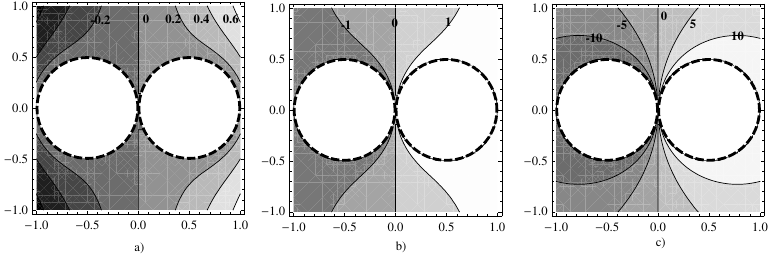
Figure 3. Modulus of the flux in the domain with a 2 = − a 1 = 0 . 5, δ = 0 . 01 in the presence of the external flux (1 , 0) and the dipole α of intensity α . Data and u 0 are for: a) z α = 0, u 0 = 0 . 070534; b) α = 0 . 1, u 0 = 1 . 488296; c) α = 1, u 0 = 14 . 24816. Labels to contour lines are written.